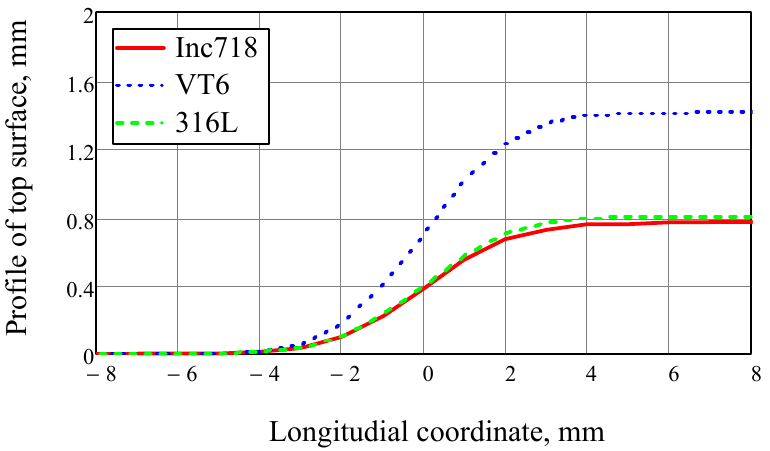
Figure 3. Melt pool top surface profiles for Inconel718, VT6, and 316 L steel in comparison with one another. Motion speed was 20 mm/s, laser beam power was 2000 W, laser beam radius on the surface was 2.5 mm, powder jet diameter was 3 mm, and powder feed rate was 2 kg/h. The impact of the heated powder jet on the surface temperature distribution along melt pool surface is shown in Figure 4.